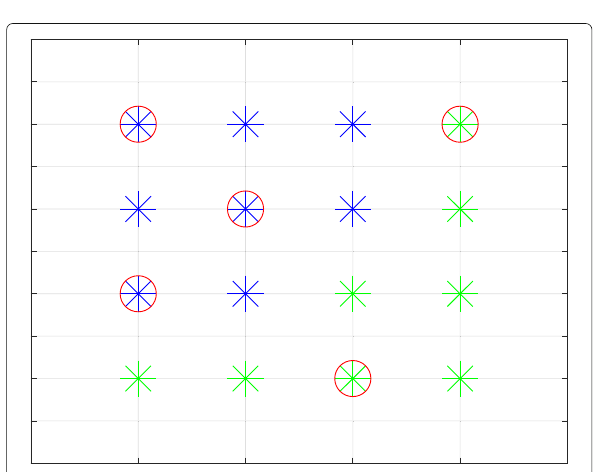
Fig. 19 The grouping result of the proposed dynamic geo-based resource selection algorithm (DGRSA) when jam areas are area 1, 3, 6, 12, and 13. There are 16 stars representing our 16 geographic areas. And thestarsaroundwith red circle are the jam areas. After performing the proposed dynamic grouping method, two geographic area groups are distinguished with different colors in the figure